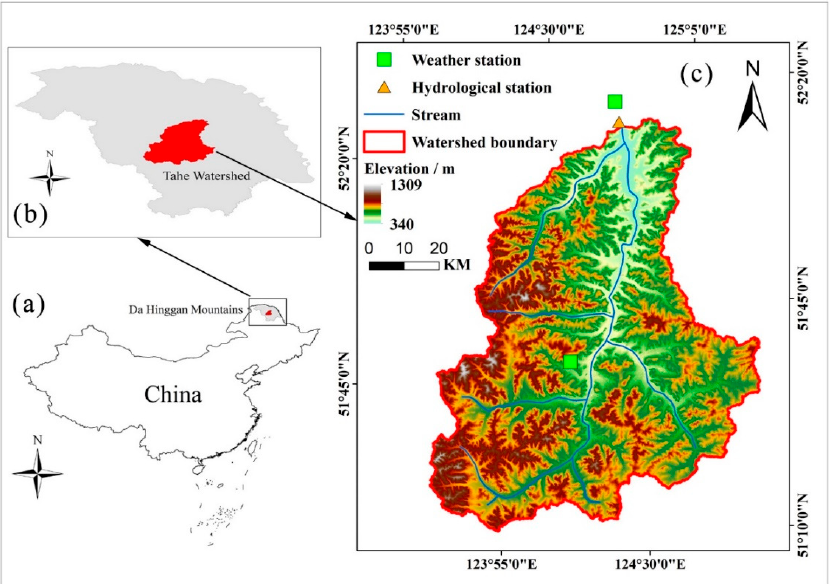
Figure 1. ( a , b ) Location of the study watershed in the Da Hinggan Mountains, China, ( c ) location of two